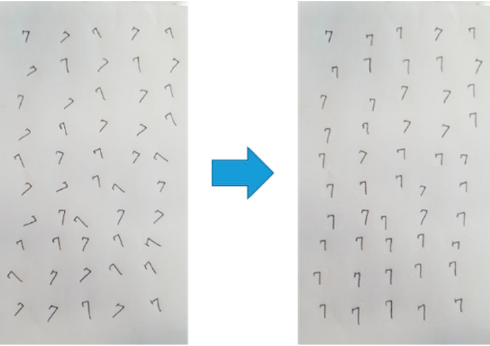
Figure 20. Tilt correction examples of “7” following the proposal ( left : original, right : tilt correction results).